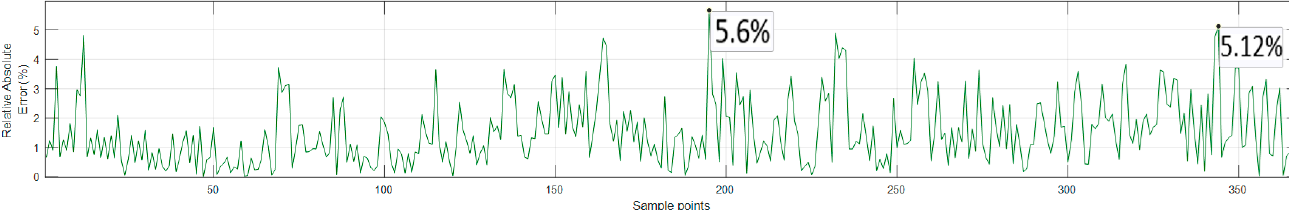
Figure 10. Remanence vs Coercivity plot for different Neo-Magnet Grades -Separate cases for model